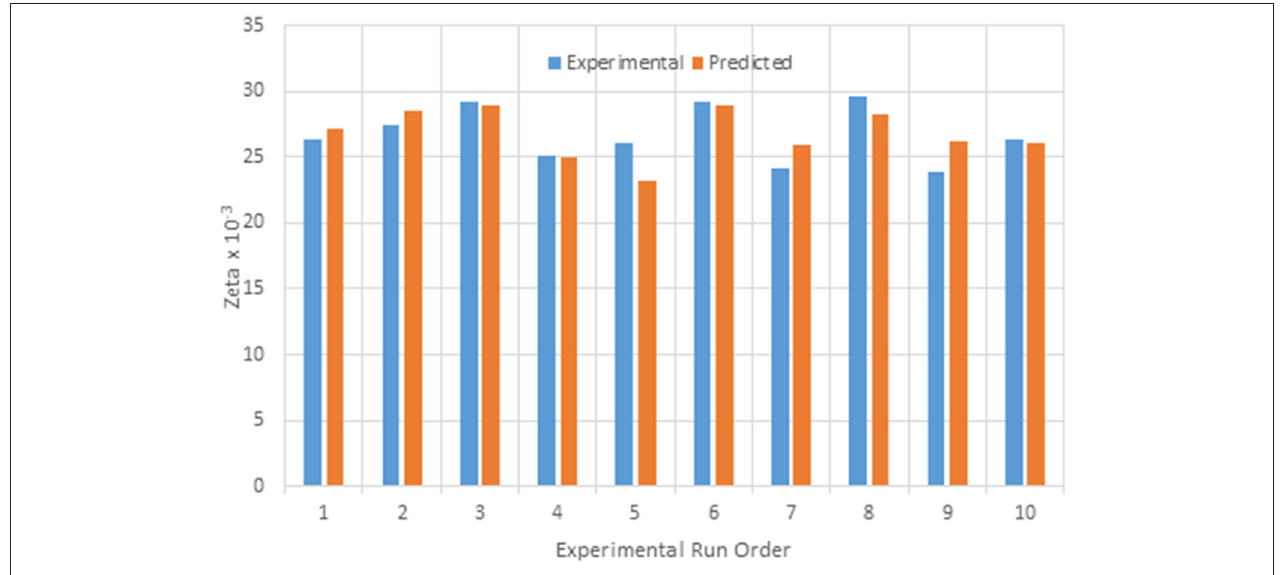
FIGURE 9 | Comparison of experimental and predicted values of Zeta.